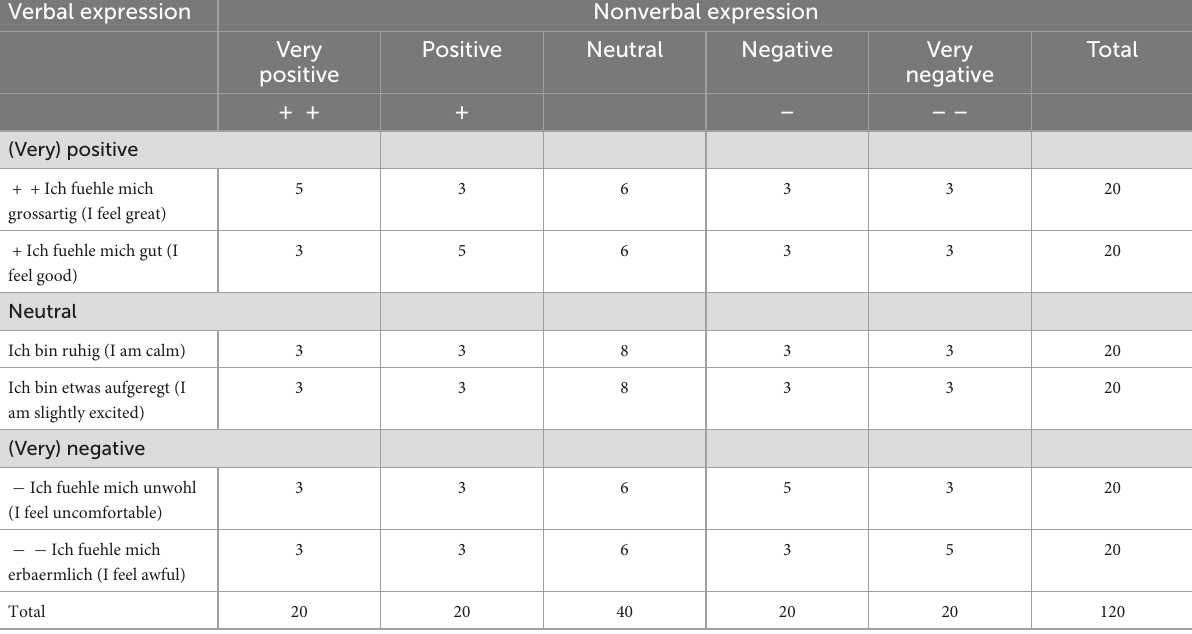
TABLE 2 Stimulus material for all combinations of verbal and nonverbal